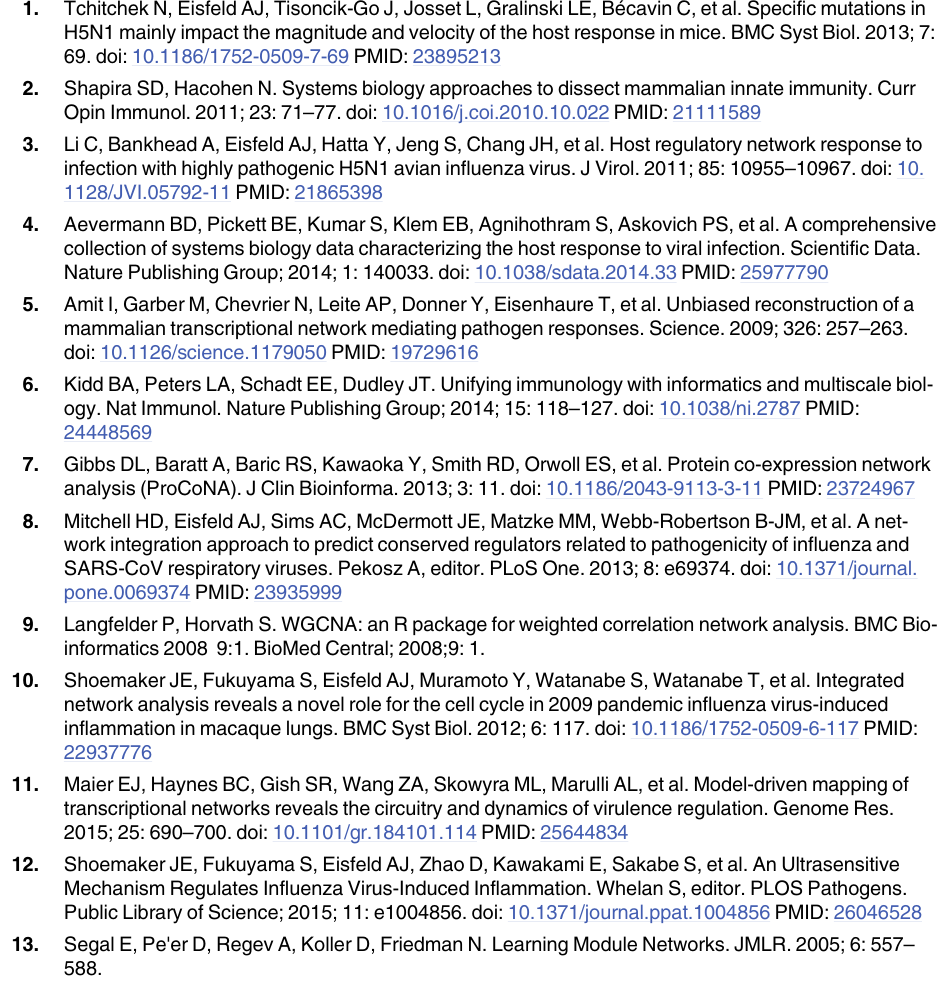
S1 Dataset. Plots showing MTG-LASSO predictive quality of each module vs. lambda, mea- sured by Pearson correlation. One plot per module, both